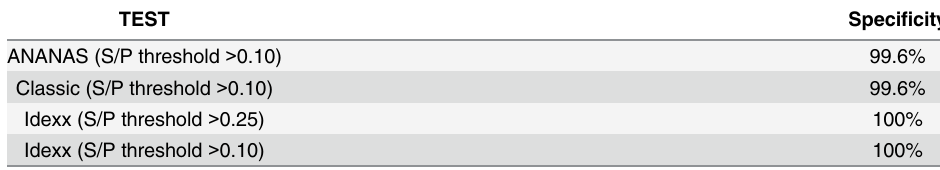
Table 1. ELISA test specificity comparison. Assay specificity calculated for the classic method based on 1G10-HRP conjugate, the 1G10-ANANAS integrated, and the commercial IDEXX one. Results of the IDEXX test were interpreted adopting the S/P threshold indicated by the manufacturer (0.25) or the same one adopted for the 1G10 based methods (0.1). The results have been obtained using 252 negative tank